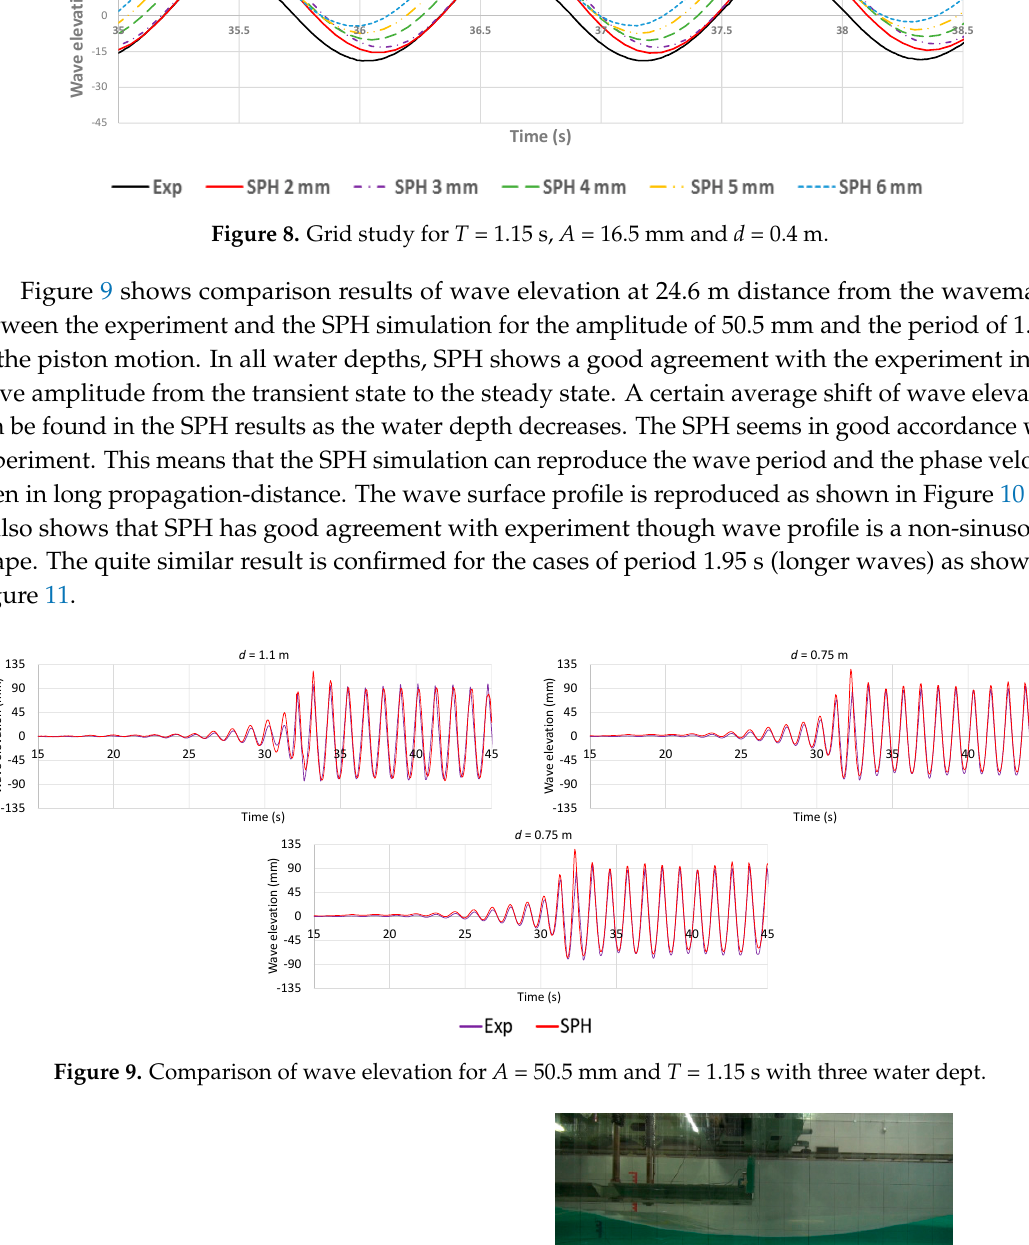
Figure 8. Grid study for T = 1.15 s, A = 16.5 mm and d = 0.4 m. Table 5. Particle spacing and total particles for grid study.